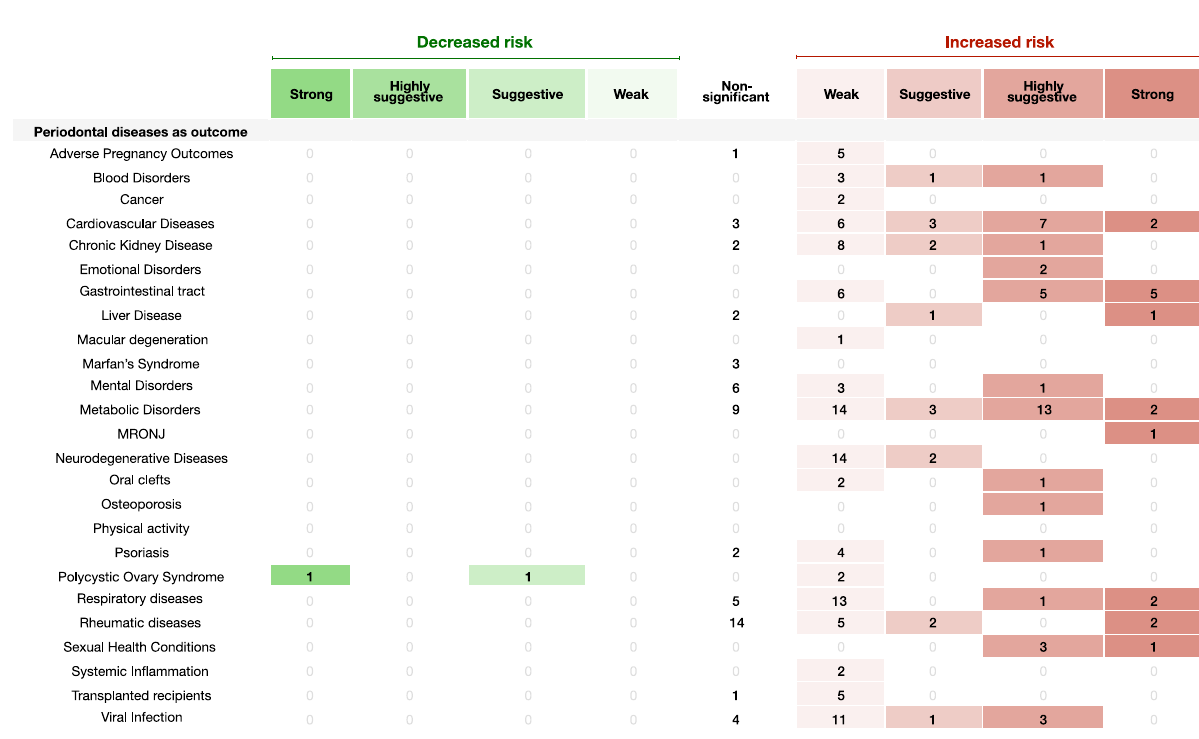
reducetherisk(ingreen).APOsadversepregnancyoutcomes,CVDscardiovascular diseases, CKD chronic kidney disease, Dis. disease. Source data are provided as a Source Data fi